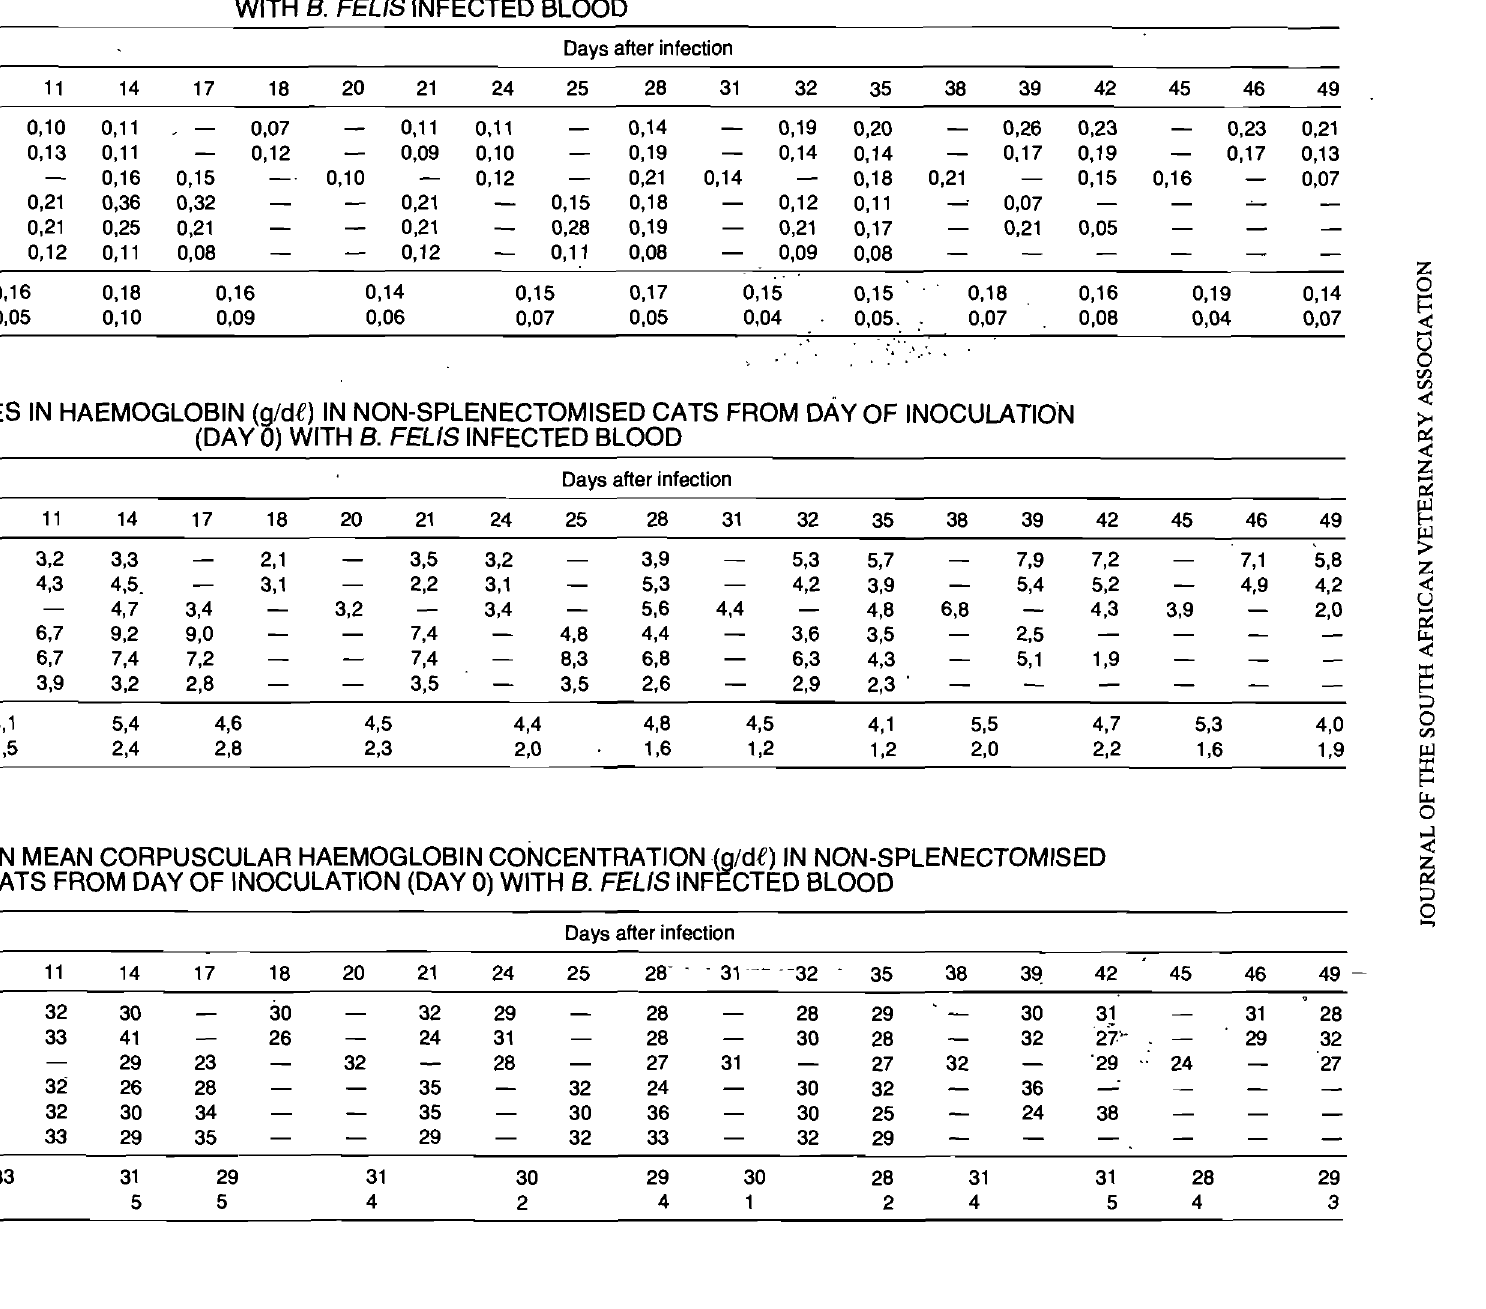
Table 9: CHANGES IN MEAN CORPUSCULAR HAEMOGLOBIN CONCENTRATION~/df) IN NON-SPLENECTOMISED ~ Cats Days after infection